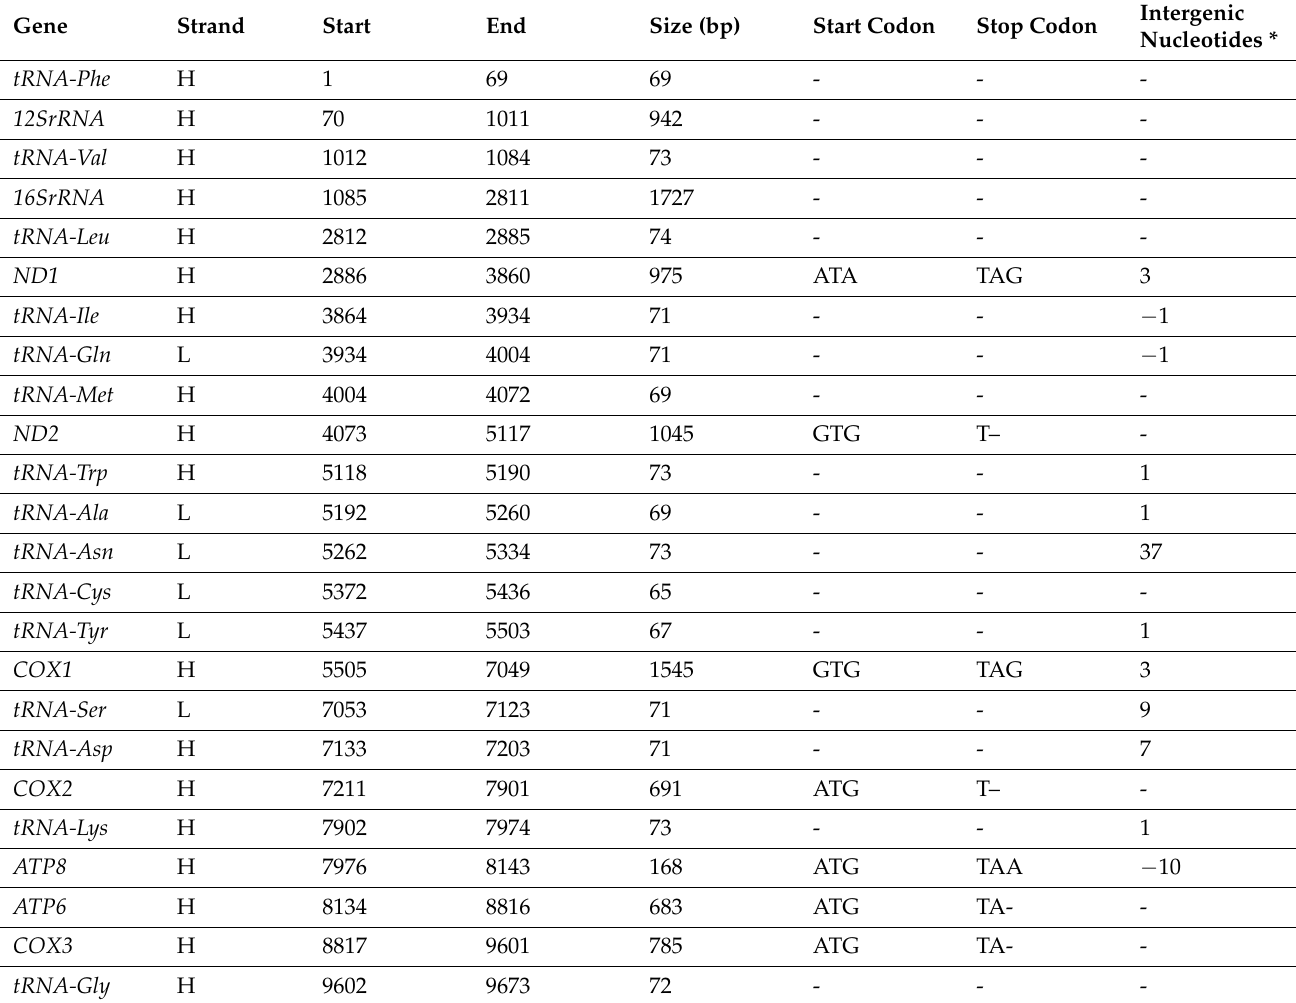
Table 2. Gene order of the complete mitogenome of the Pseudorhombus pentophthalmus